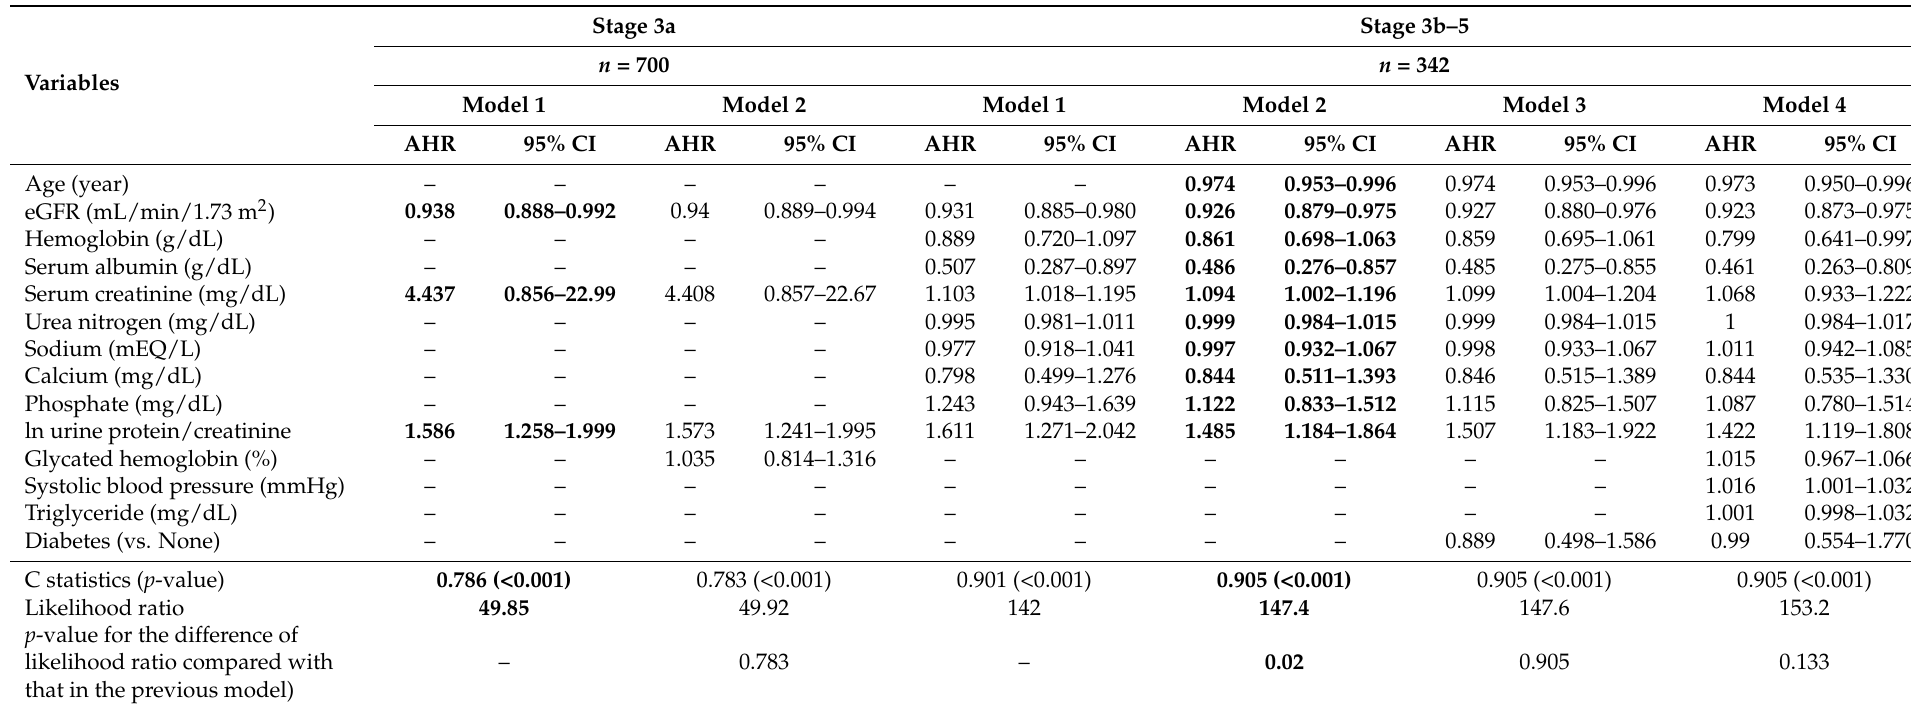
Table 3. Adjusted hazard ratios (AHR) for the effects and goodness of fit of the variables on the risk of dialysis treatment in the baseline